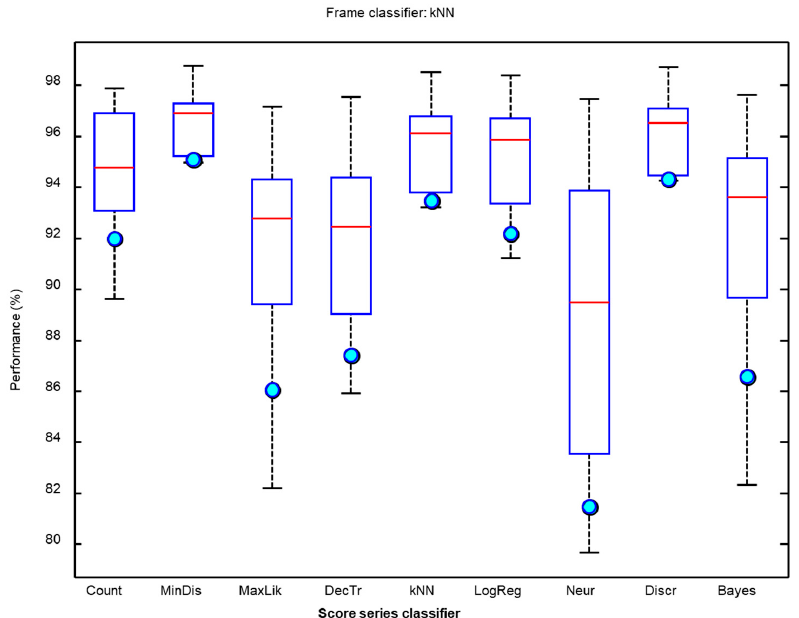
Figure 14. Boxplot of the performance metrics for the different classifiers of score series operating on